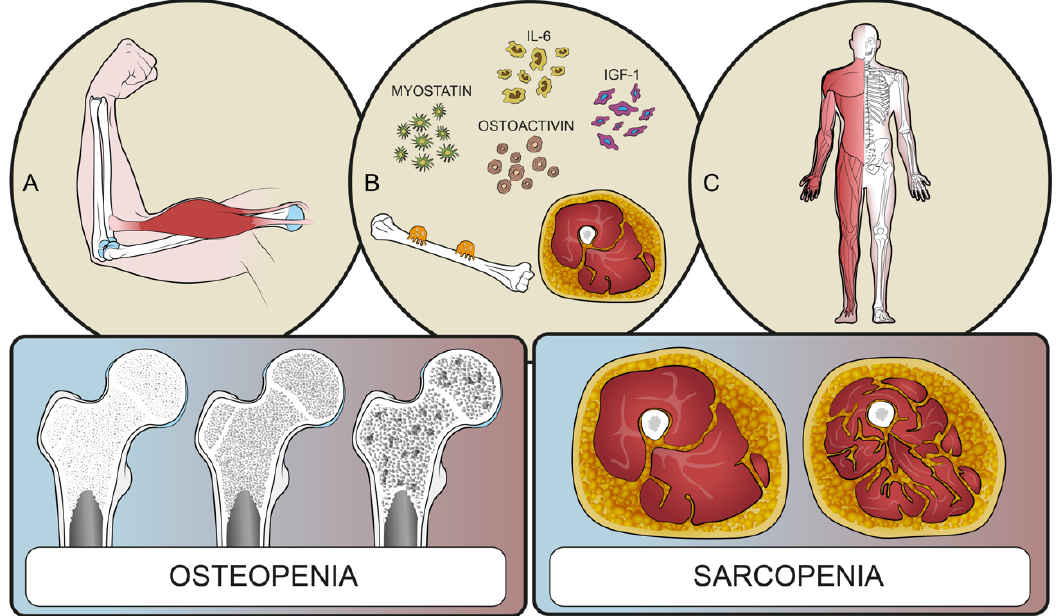
Figure 1. Interactions between bone and muscle tissues. ( A ) Muscles and bones interact with each other to ensure movement; ( B ) bone and muscles share common pathways involving inflammatory cytokines and catabolic metabolites; ( C ) muscles line the bones constituting a functional unit. These interactions could explain the common pathogenesis of sarcopenia, osteopenia, and frailty